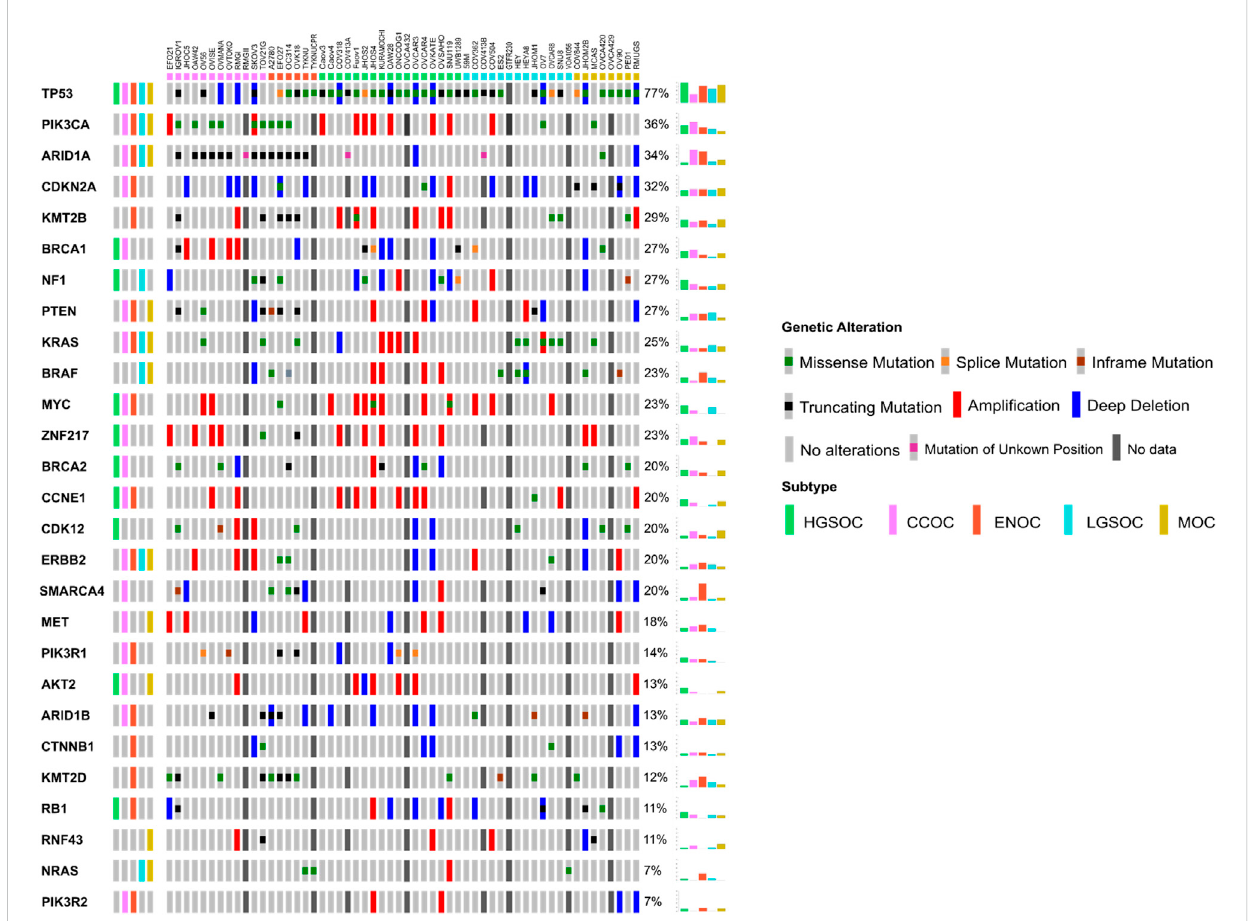
FIGURE 3 Oncoprint detailing the mutational and copy number landscape of 56 EOC cell lines in 27 genes commonly mutated in ovarian cancer, ordered by mutation frequency. Commonly mutated genes in each of the fi ve subtypes were determined from a literature search (Supplementary Table S4) and shown in the leftmost column. Colored boxes on the top of the Oncoprint delineate the putative subtype of cell line samples as assigned by NMF. Mutation and/or copy number data was unavailable for a number of samples (see Materials and Methods) and are delineated with a dark grey box. Overall frequency of alteration/mutation for each gene in EOC cell lines by putative subtype are displayed in the rightmost